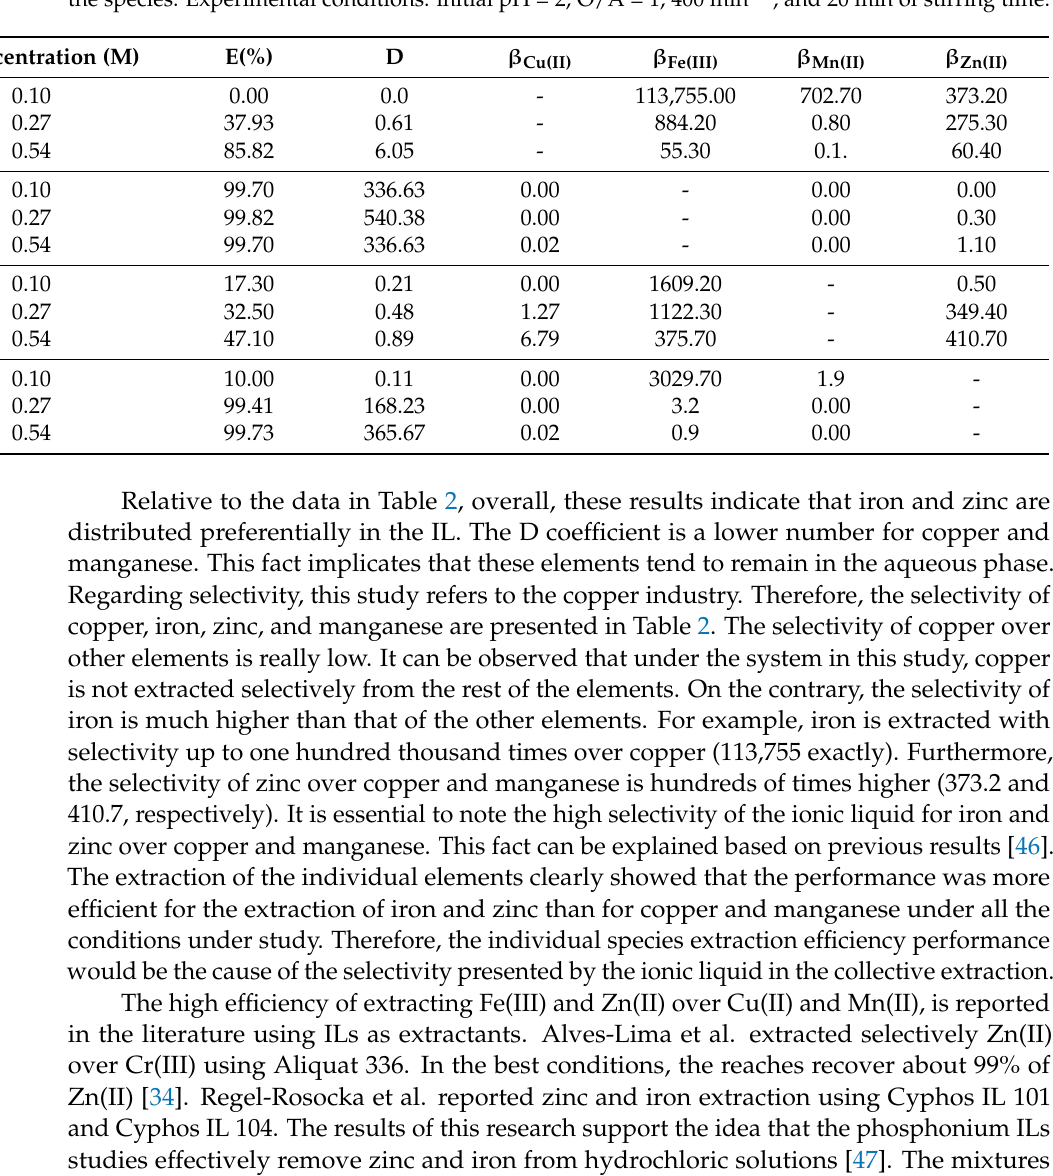
Table 2. Effect concentration of R 4 NCy on extraction efficiency, distribution ratio and selectivity of the species. Experimental conditions: initial pH = 2, O/A = 1, 400 min − 1 , and 20 min of stirring